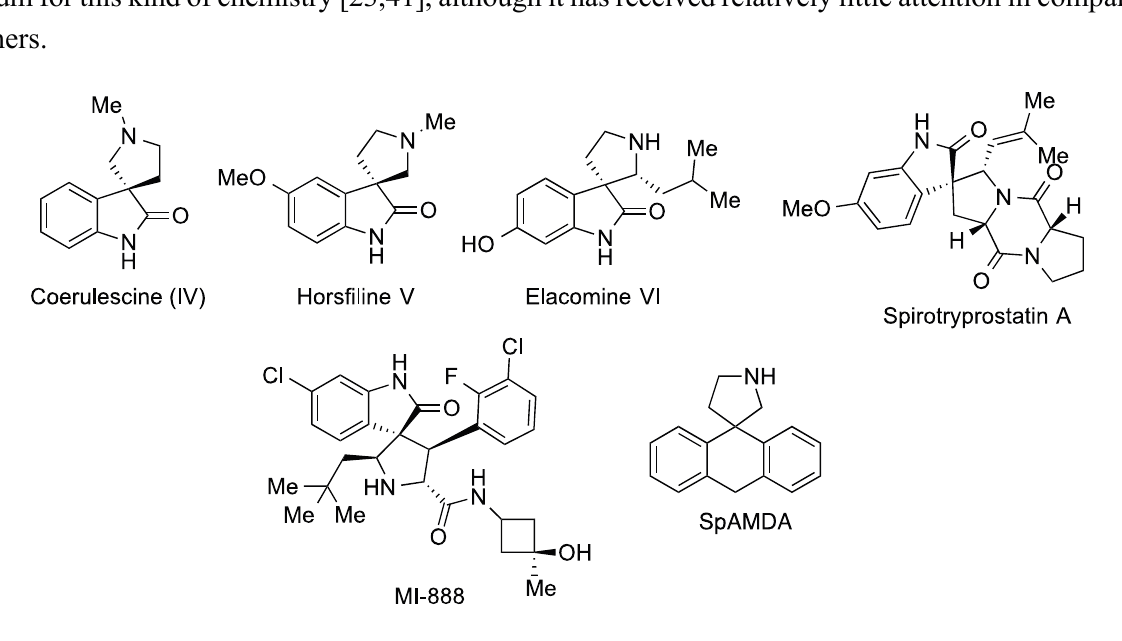
Figure 1. Some biologically relevant derivatives of the spiro[9,10]dihydroanthracene [9,3 ′ ]- pyrrolidine and spiro[oxindole-3,2 ′ -pyrrolidine] frameworks.